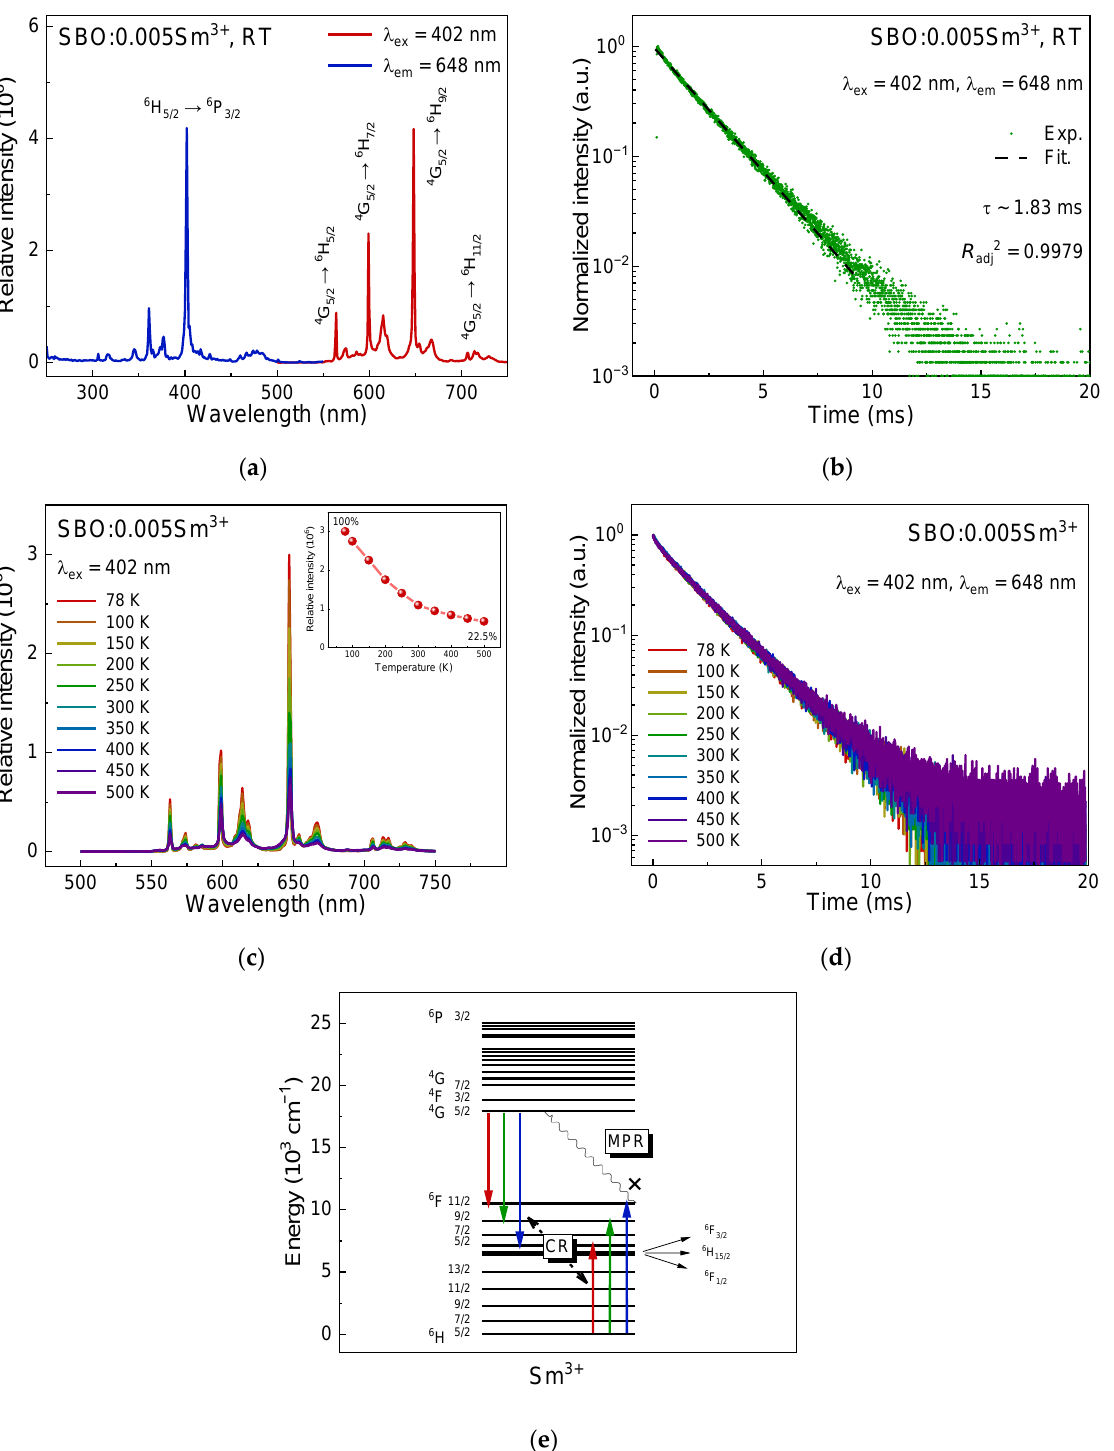
Figure 2. ( a ) Excitation (λ em = 648 nm) and emission spectra (λ ex = 402 nm) of SBO:0.005Sm 3+ at RT;